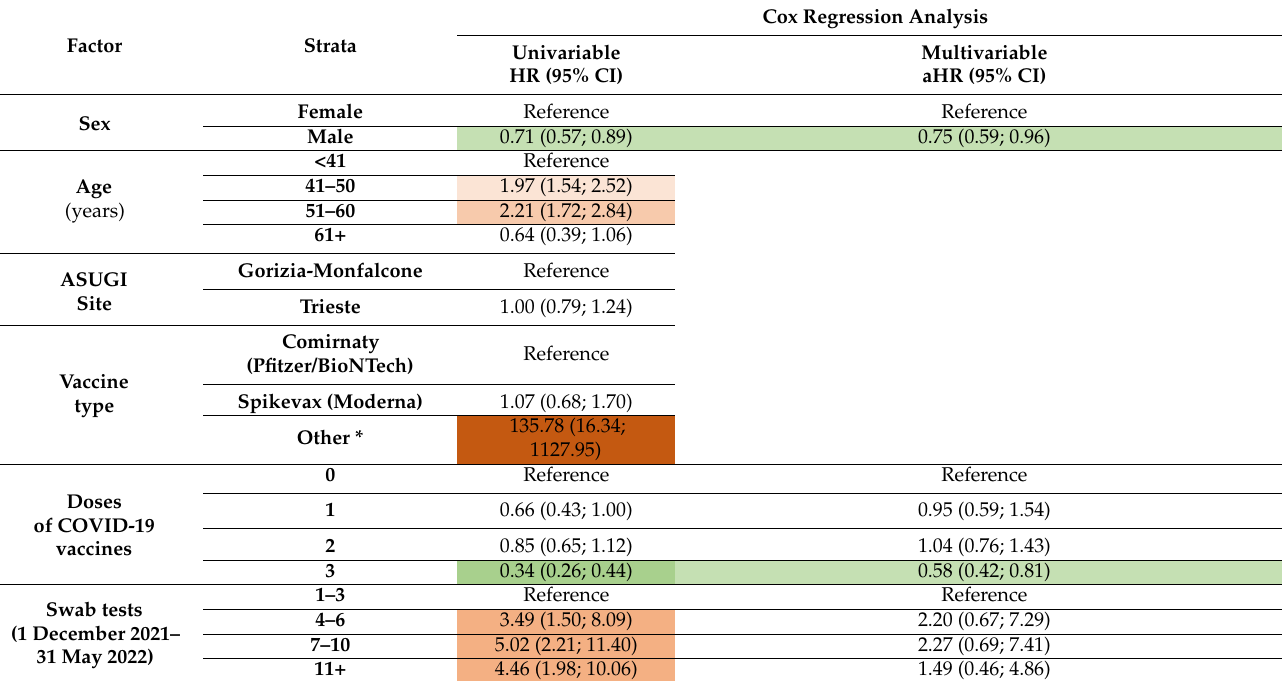
Table 5. Cox proportional regression model for the risk of SARS-CoV-2 re-infections (1 December 2021–31 May 2022). Hazard ratio unadjusted (HR) and adjusted (aHR), with 95% confidence